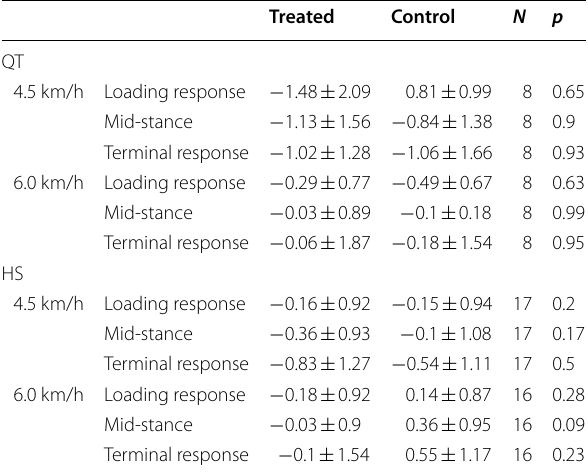
Table 1 Mean values and standard deviations of the varus– valgus angles for the treated and contralateral intact knees in the QT and HS group during the loading response, mid-stance and terminal stance at 4.5 km/h and 6.0 km/h Treated